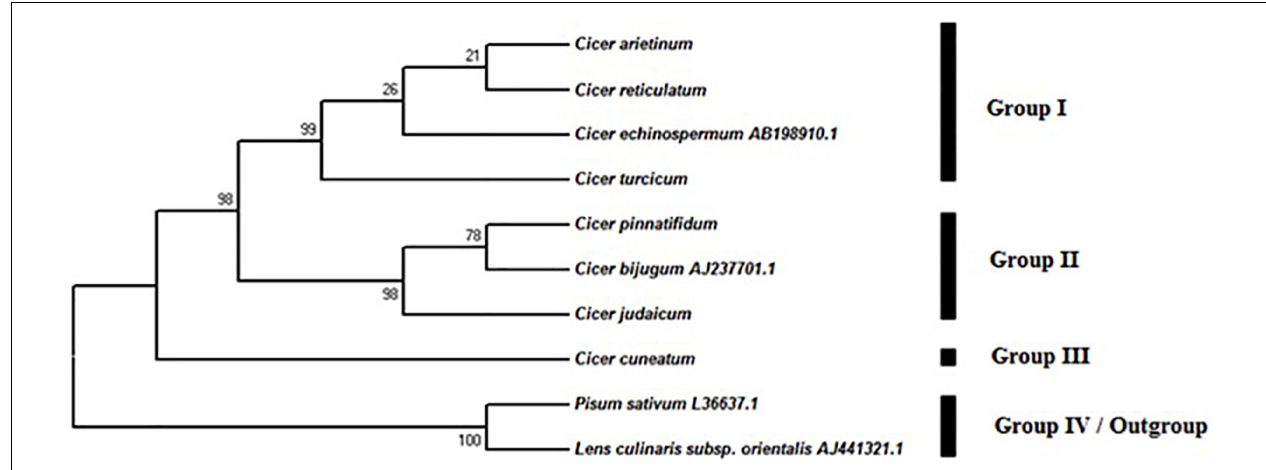
FIGURE 5 | Phylogenetic tree from the maximum parsimony analysis based on the sequence of ITS region in Cicer taxa.